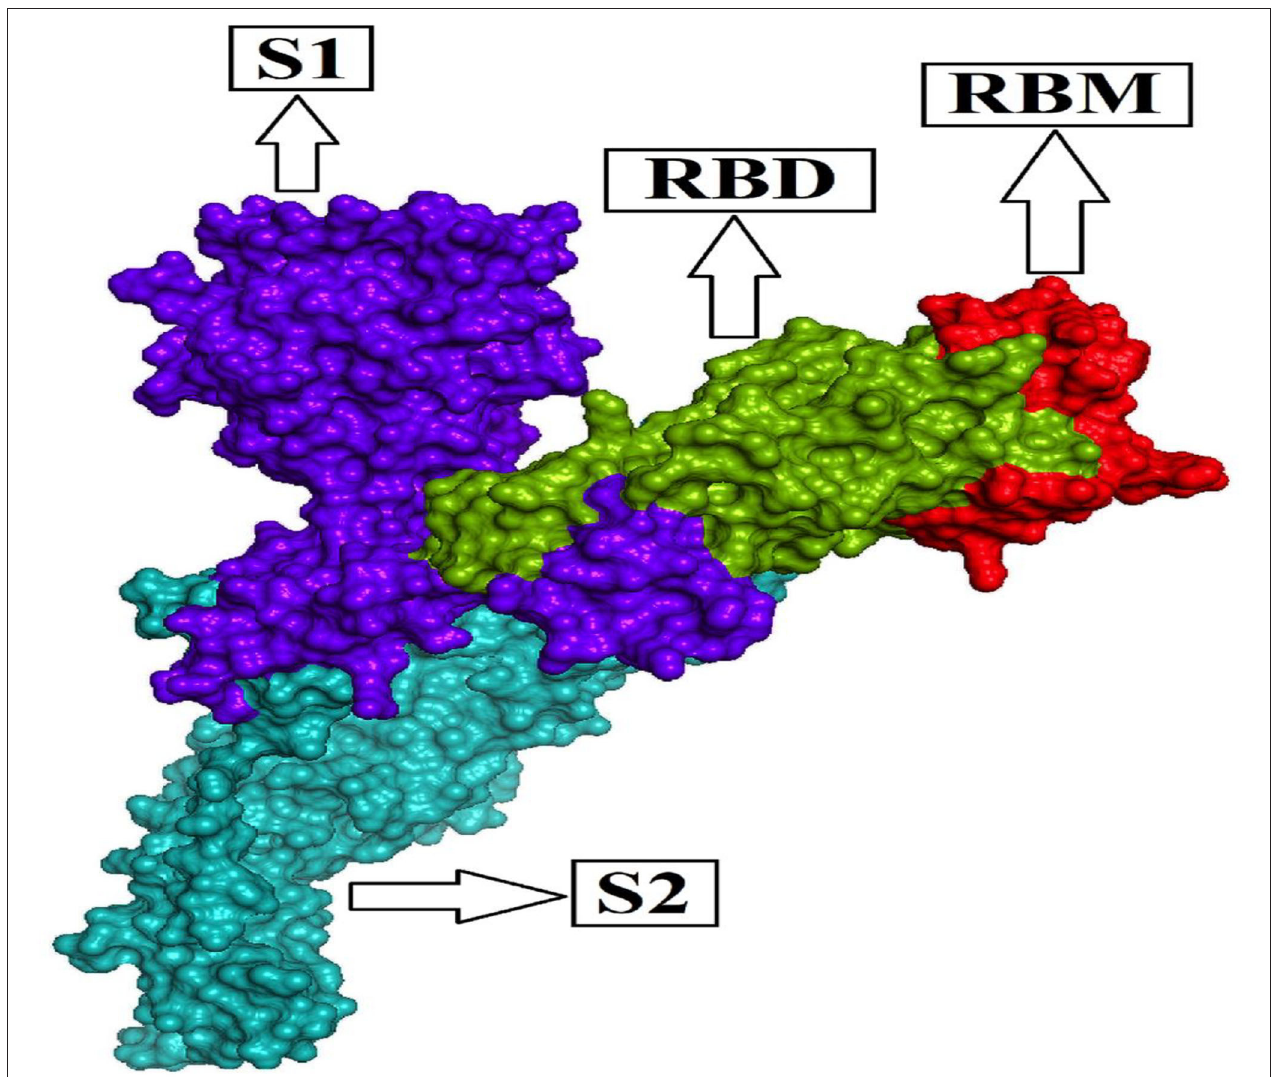
FIGURE 1 | Functional subunits of the spike glycoprotein (S) of SARS-CoV-2.